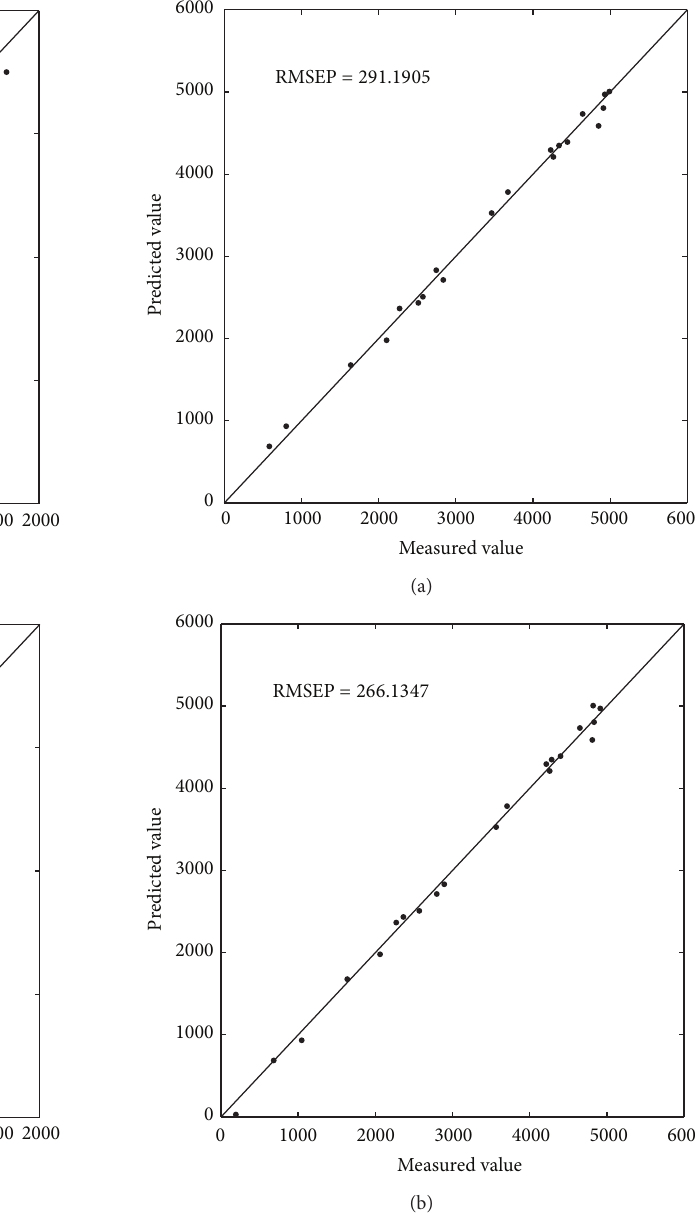
Figure 4: Prediction value versus measured value scatter diagram of different methods for CO 2 . (a) PLS; (b)